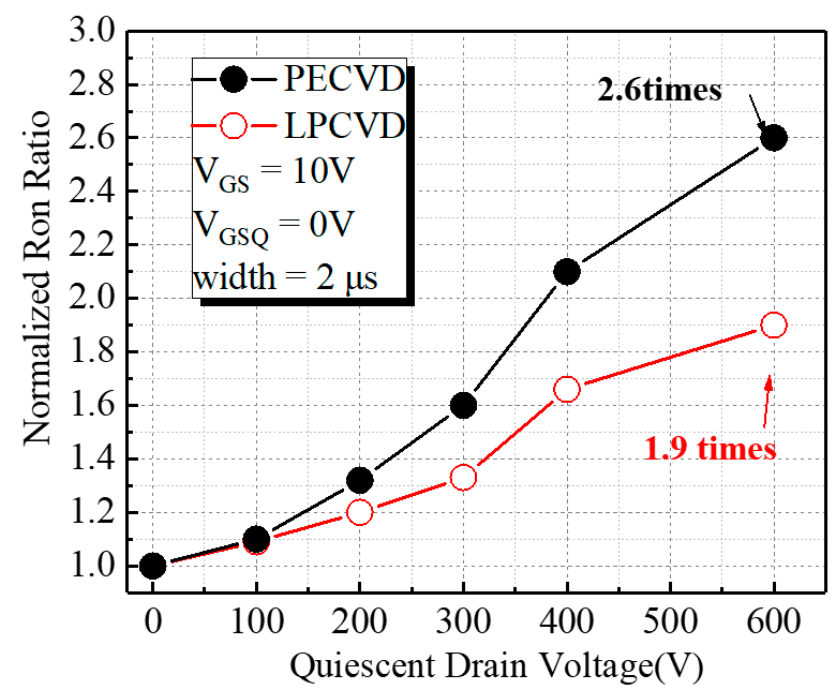
Figure 7. The dynamic R on ratio of the PECVD- and LPCVD-MISHEMT.